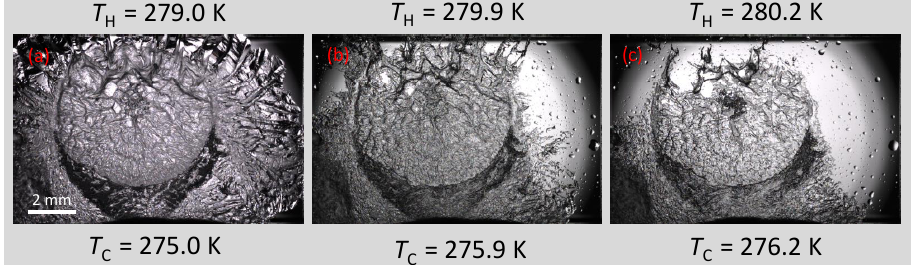
Figure 7. Dissociation sequence of a methane hydrate formed from an aqueous MEG solution, with applied temperature gradient. w MEG = 10%, p = 5.99 MPa, T HLV = 279.7 K. ( a ) Before hydrate dissociation. ( b , c ) Irregular pattern of hydrate dissociation.